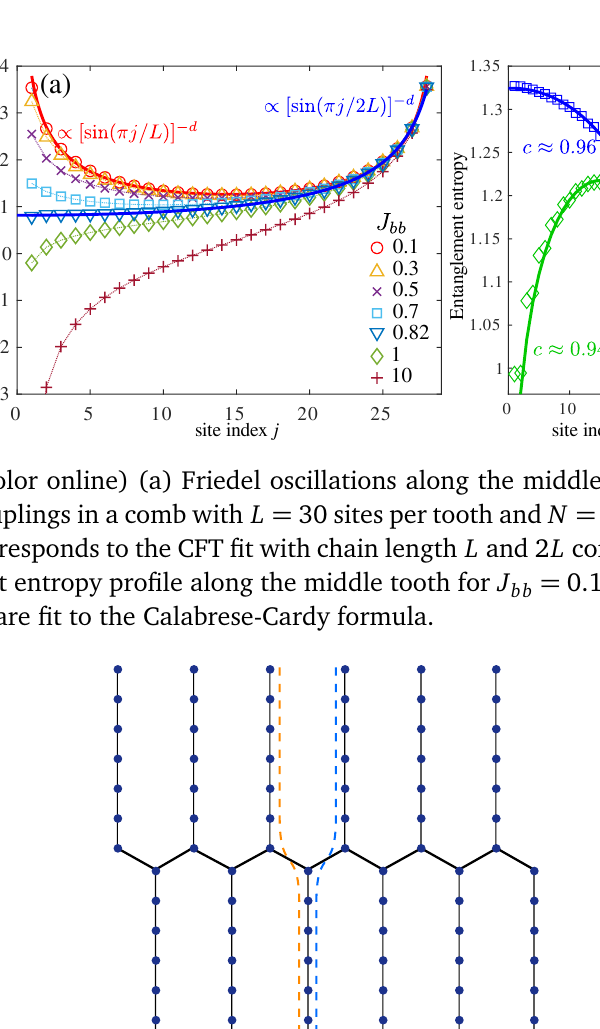
Figure 9: (Color online) Alternative representation of a comb geometry. When the backbone interaction is comparable to the interaction within the teeth, the system can be viewed as a collection of one-dimensional chains (dashed lines) with the distortion in the middle of the